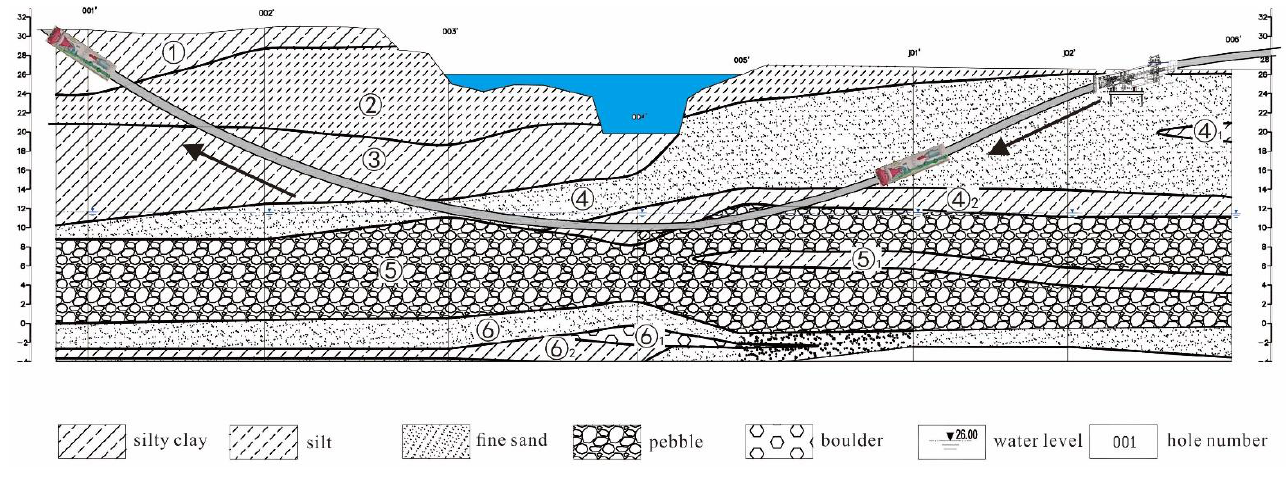
Figure 2. Figure of overall layout of construction site.